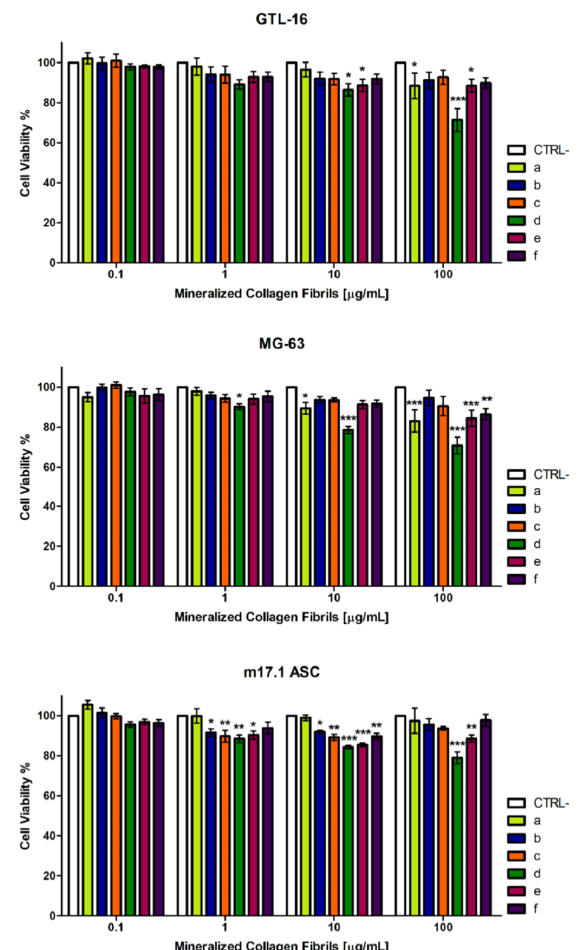
Figure 8. Cytocompatibility of the different Eu – doped and citrate – coated apatite mineralized collagen fibrils. GTL – 16, MG – 63 and m17.ASC cells were incubated with the different types of fibrils (a, Col/Ap; b, cit high – Col/Ap; c, cit low – Col/Ap; d, Col/Ap – cit high ; e, cit high – Eu/Col/Ap; f, Eu/Col/Ap) for three days and